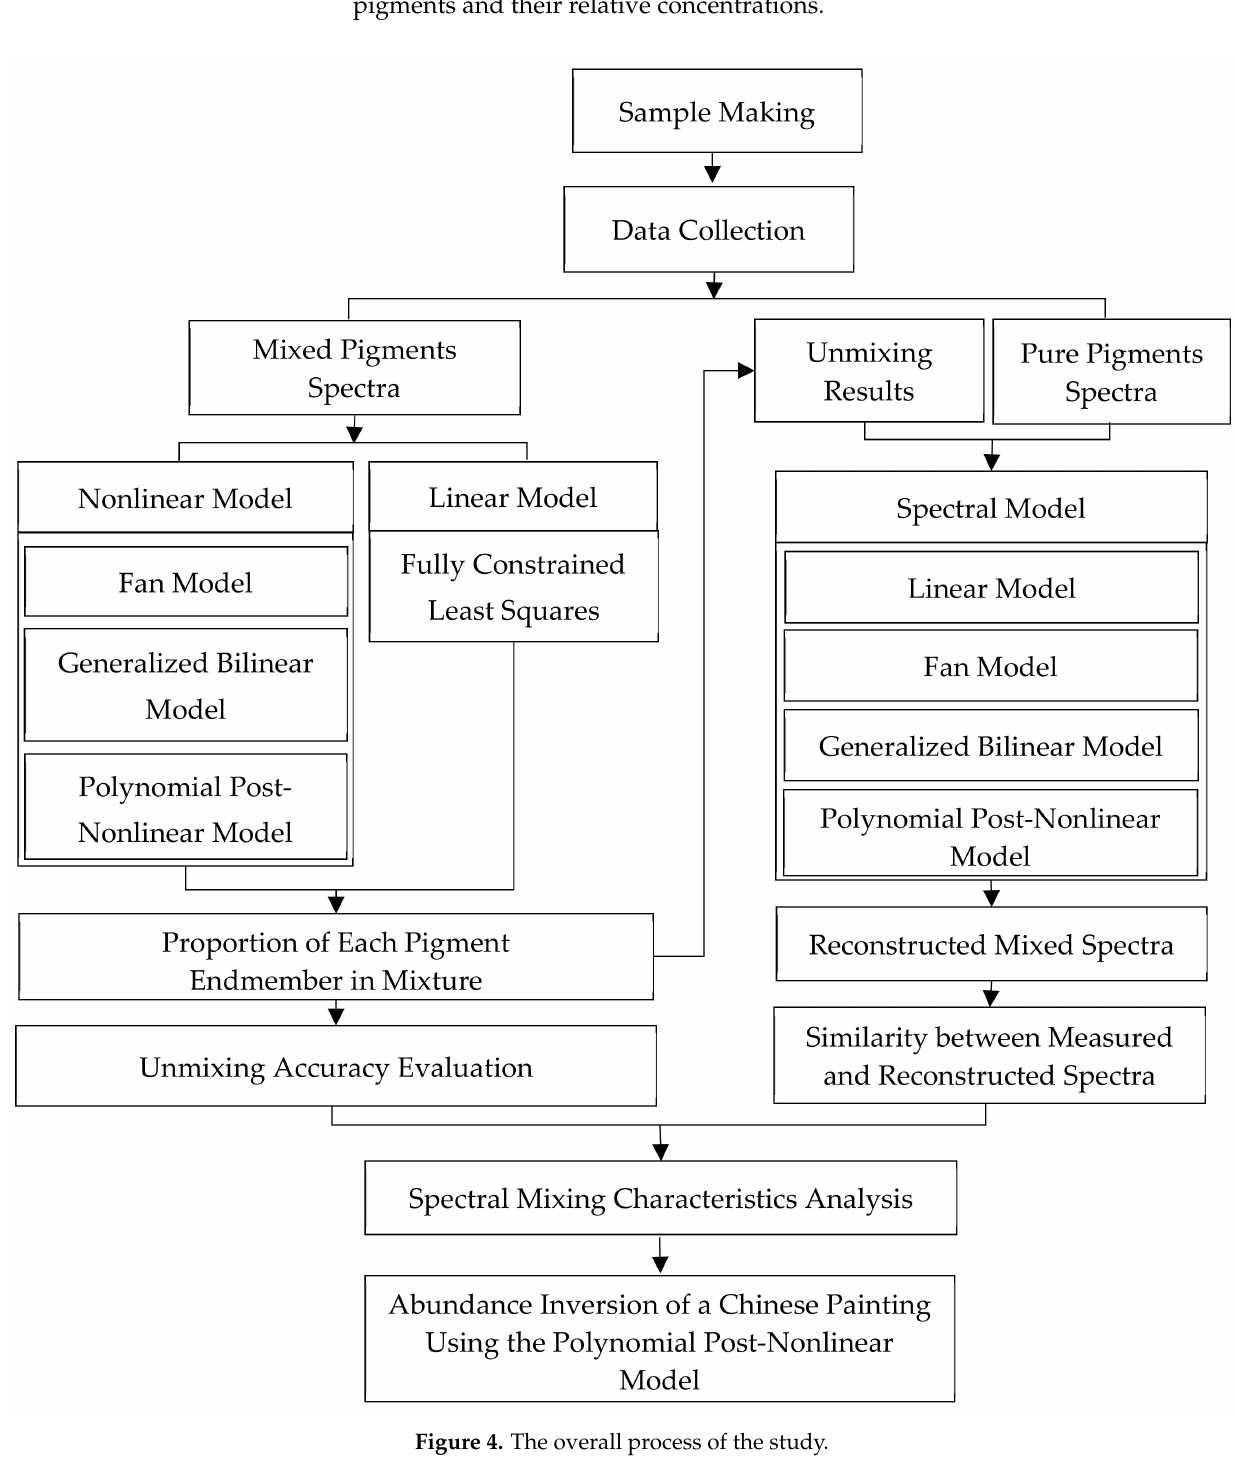
Experiment with a Chinese painting. The PPNM algorithm was selected to study a Chinese painting to evaluate the nonlinear model’s ability to correctly estimate the pigments and their relative concentrations.